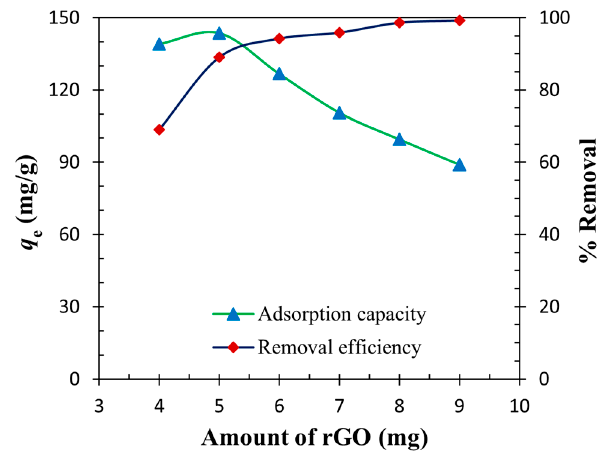
Figure 14. Effect of the mass of rGO on the adsorption process ( C MB0 = 20 mg/L, V = 50 mL, T = 298 K).